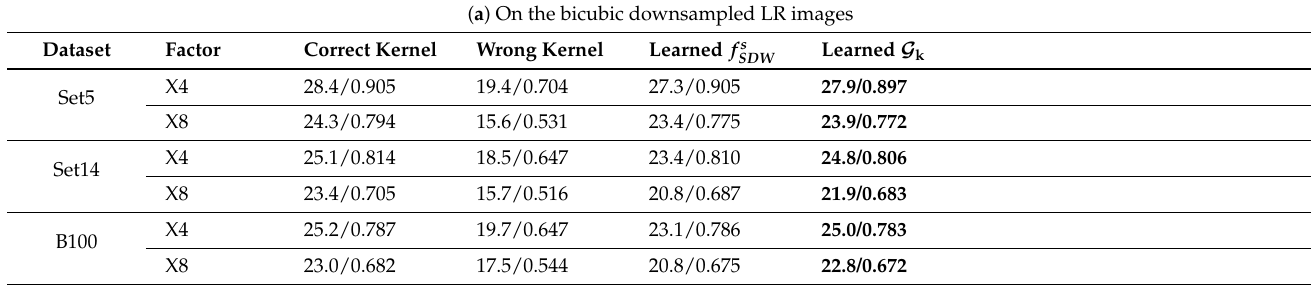
. ( a ) On the bicubic SDW